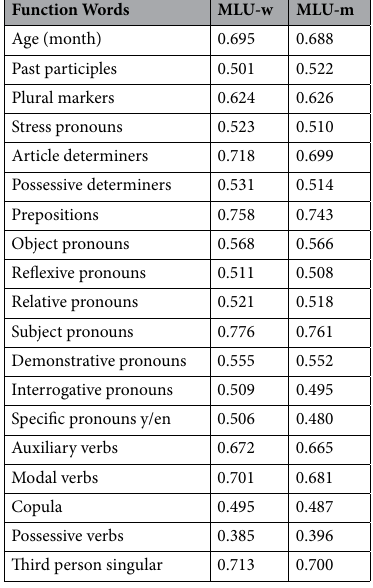
Table 2. Correlations between age, 18 FWs and MLU-w,